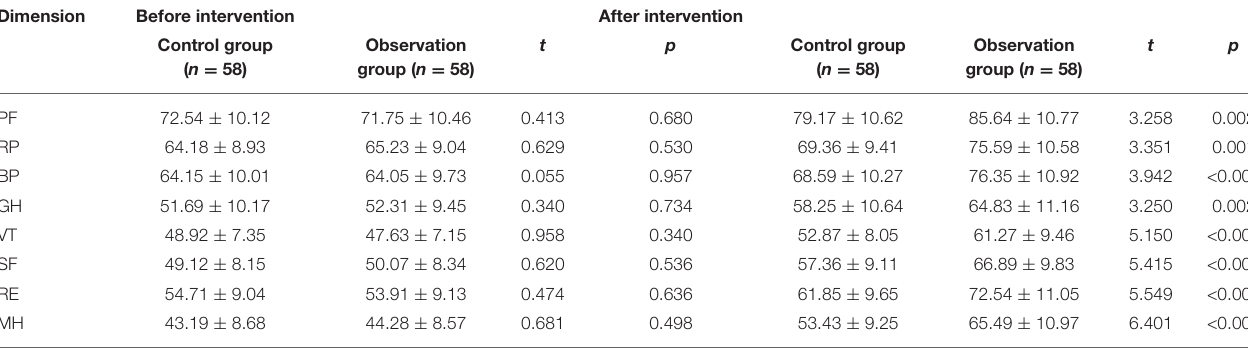
TABLE 4 | Comparison of MOS 36-item short-form health survey (SF-36) scores in each dimension between the two groups of patients (¯x ± s, points). Dimension Before intervention